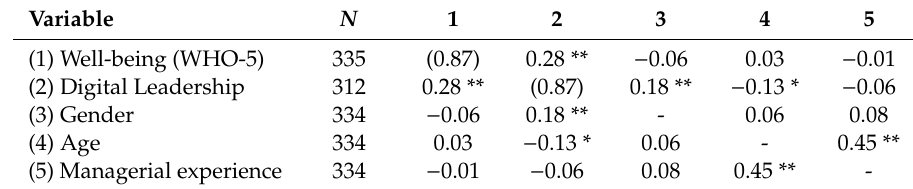
Table 2. Correlations between the